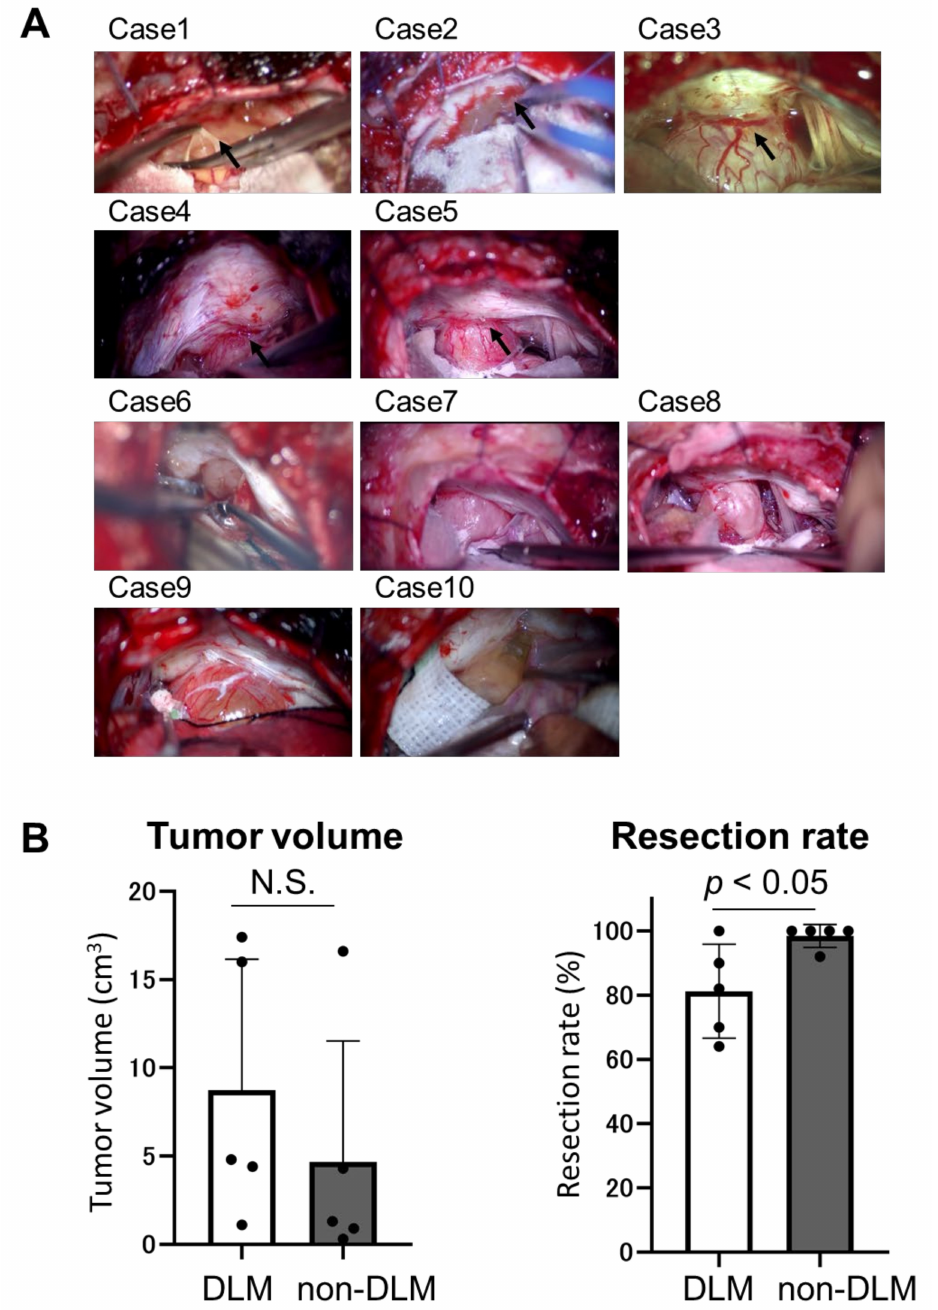
Figure 1. Tumor characteristics. DLM, dura-like membrane. ( A ) Tumors with and without dura- like membrane (DLM). DLM (black arrow) is observed in Cases 1–5, and not observed in Cases 6–10. DLMs contain the dense dilated vessels from the originated dura mater. These vessels are continuously observed on the surface of the tumor. In non-DLM group, these dilated vessels were not noticeable in the dura mater around the internal auditory meatus (IAM). ( B ) Tumor volume and resection rate between DLM and non-DLM group. The average tumor volumes of DLM group and non-DLM group are 8.7 cm 3 and 4.7 cm 3 , respectively ( p = 0.39). The resection rate of the DLM group is significantly lower than that in non-DLM group (81.2% and 98.4%, p < 0.05). N.S.: not